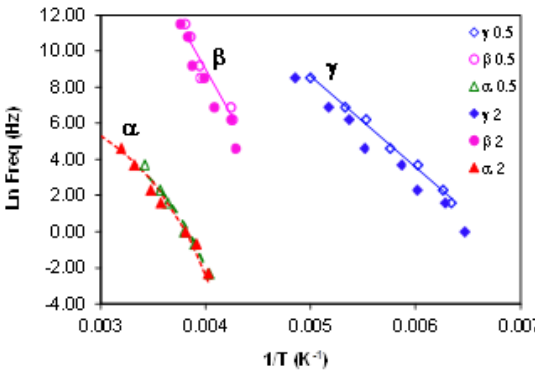
Figure 7. Relaxation map for HBPEI at two different heating rates: 0.5 K/min (open symbols) and 2 K/min (filled symbols).